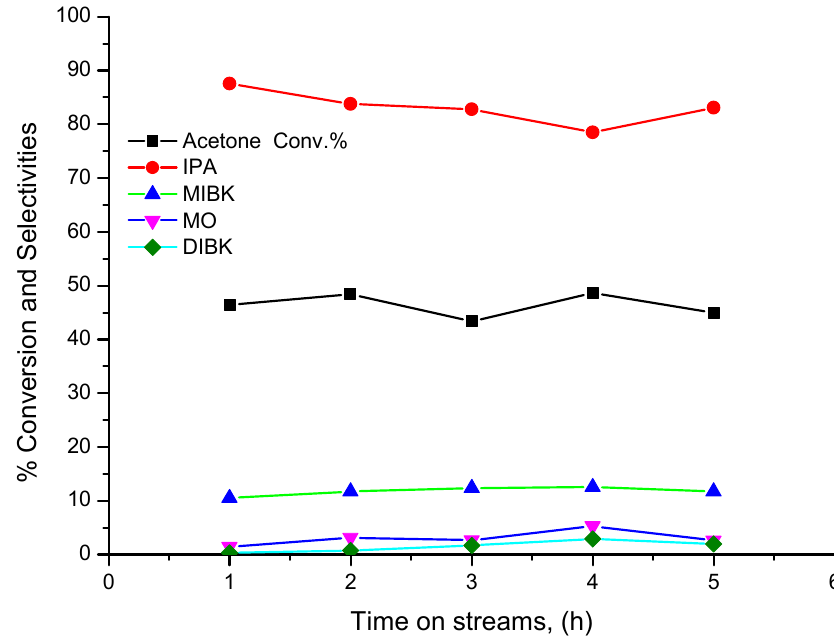
Figure 5. Product selectivities and acetone conversion over CAT-IV catalyst. Reaction conditions: 0.25 g catalyst, t = 250 °C, H 2 /acetone mole ratio = 6:1.